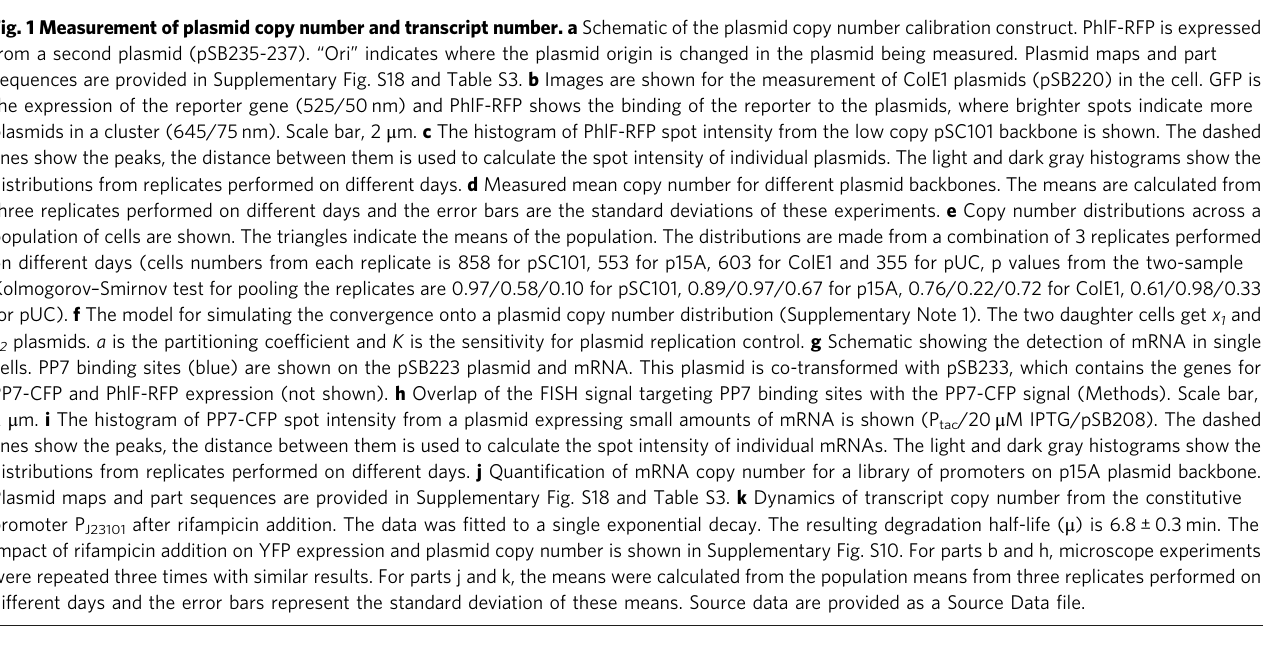
Fig. 1 Measurement of plasmid copy number and transcript number. a Schematic of the plasmid copy number calibration construct. PhlF-RFP is expressed from a second plasmid (pSB235-237). “ Ori ” indicates where the plasmid origin is changed in the plasmid being measured. Plasmid maps and part sequences are provided in Supplementary Fig. S18 and Table S3. b Images are shown for the measurement of ColE1 plasmids (pSB220) in the cell. GFP is the expression of the reporter gene (525/50 nm) and PhlF-RFP shows the binding of the reporter to the plasmids, where brighter spots indicate more plasmids in a cluster (645/75 nm). Scale bar, 2 μ m. c The histogram of PhlF-RFP spot intensity from the low copy pSC101 backbone is shown. The dashed lines show the peaks, the distance between them is used to calculate the spot intensity of individual plasmids. The light and dark gray histograms show the distributions from replicates performed on different days. d Measured mean copy number for different plasmid backbones. The means are calculated